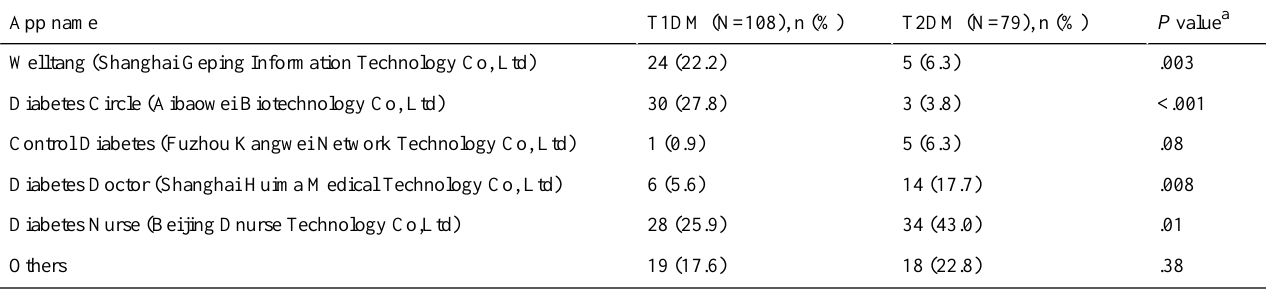
Table 4. Differences in the selection of diabetes apps between patients with type 1 diabetes mellitus (T1DM) and patients with type 2 diabetes mellitus